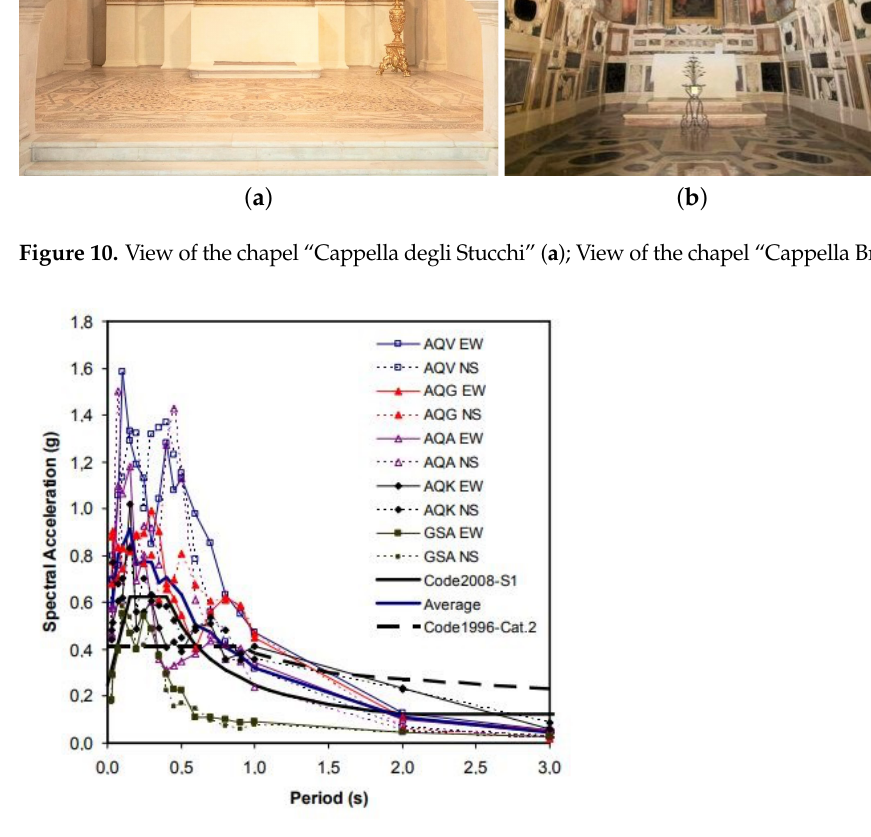
Figure 11. Response spectra of the records from 5 stations for damping and comparison with Normative code design spectrum